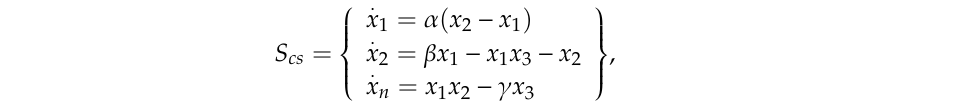
( c ) Figure 6. Chaotic scatter diagrams of each phase voltage of the inverter operating at 60 Hz and under normal switch operation: ( a ) Phase voltage v ao ; ( b ) phase voltage v bo ; ( c ) phase voltage v co .